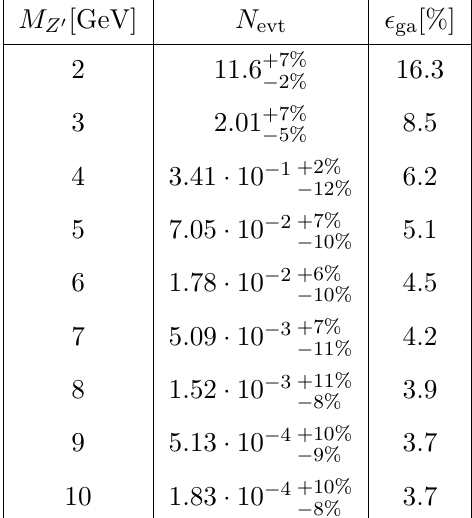
Table 3. Number of DIS dark matter scattering events ( N evt ) as a function of the mass of the scalar mediator S for the benchmark point reported in the listing in appendix D.2. (cid:15) ga is the geometrical acceptance of the detector.